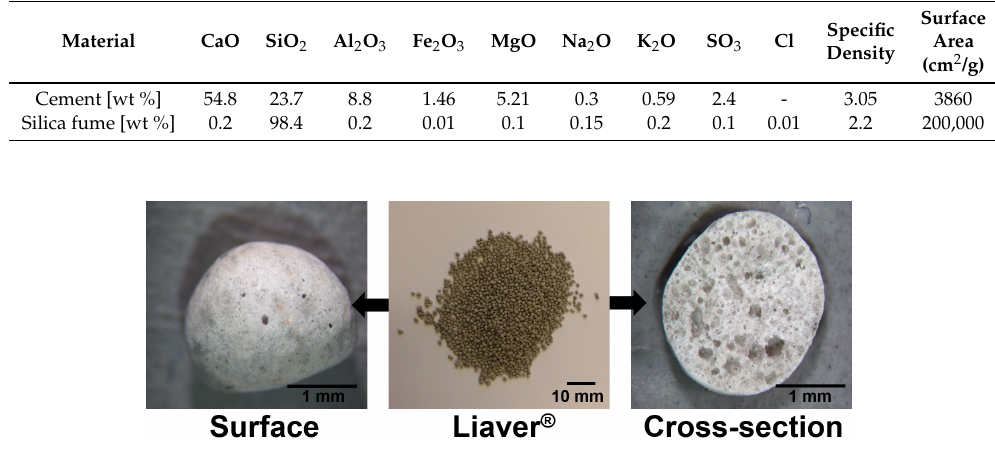
Figure 1. Expanded glass aggregate (Liaver R (cid:13) ) and its microscopy images. Table 2. Physical properties of the lightweight aggregates